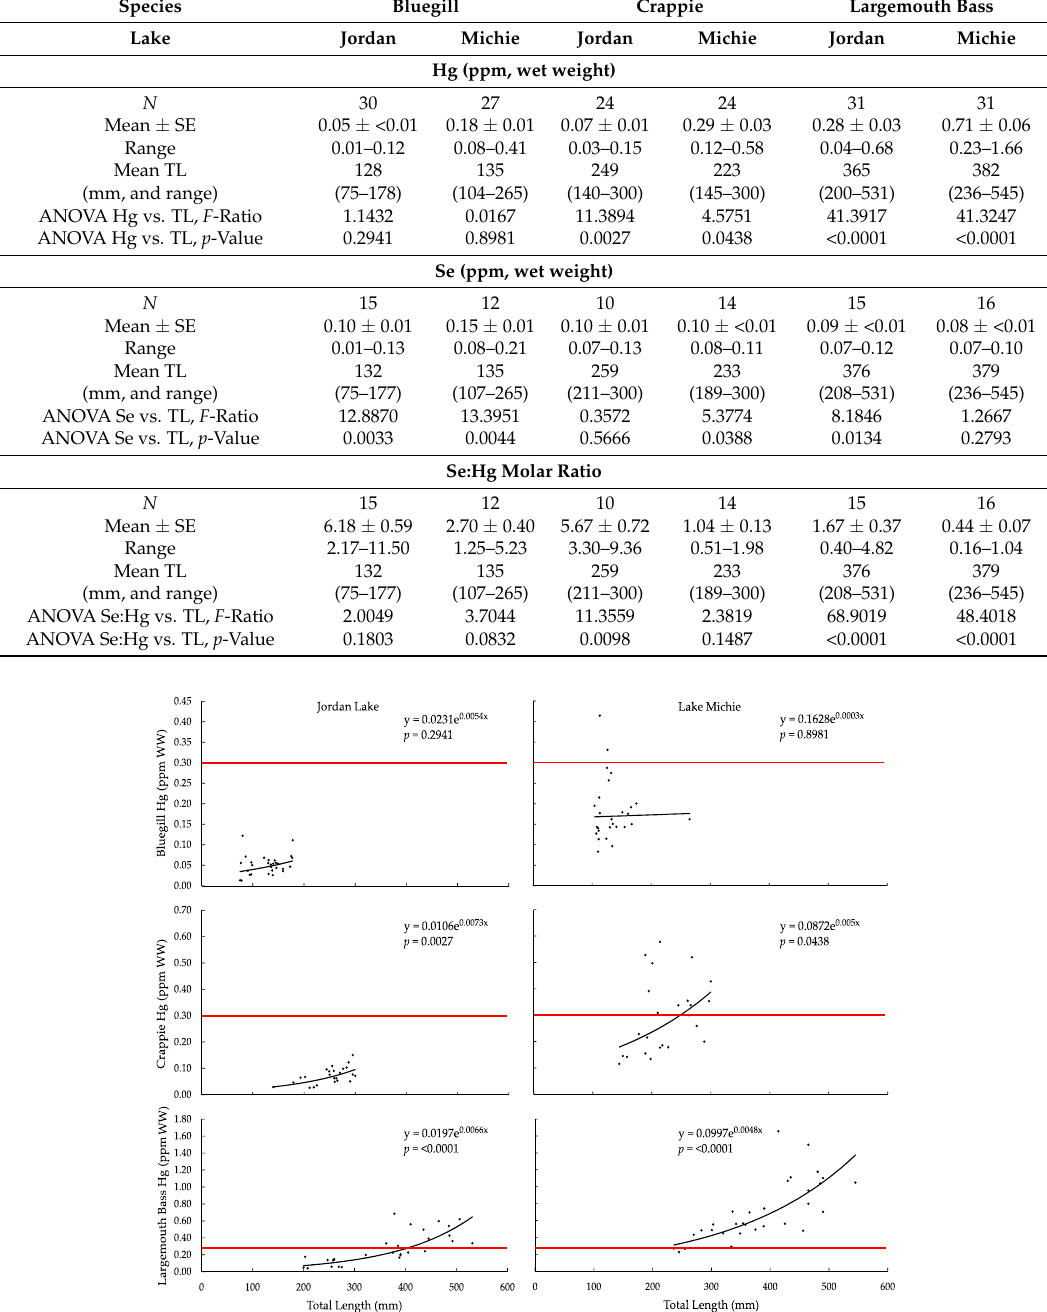
Table 3. Sample size ( N ), concentration or molar ratio mean ± standard error (SE), concentration or molar ratio range, and mean total length (TL) and range (in parentheses) for three sportfish species from two reservoirs in central North Carolina, USA. Also shown are analysis of variance results (ANOVA; α = 0.05, F -ratio, and p -value) to determine the effect of TL on measured fish tissue mercury (Hg), selenium (Se), and Se:Hg molar ratio (Se:Hg); all data were log e -transformed to comply with a normal-distribution assumption.